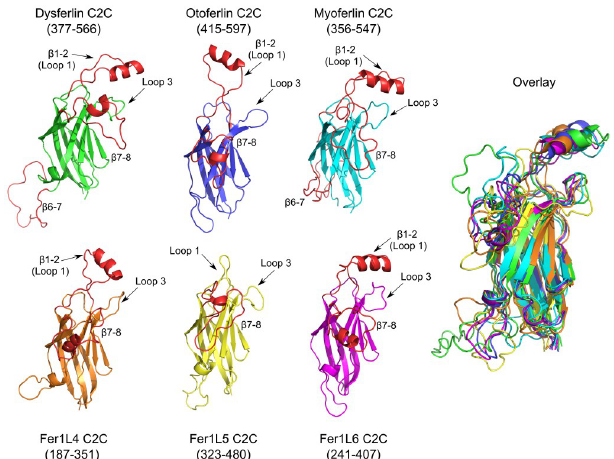
Fig 5. C2C models for dysferlin C2C (green), otoferlin C2C (blue), myoferlin C2C (cyan), Fer1L4 C2C (orange), Fer1L5 C2C(yellow), and Fer1L6 C2C (magenta). Amino acid ranges for each domain are listed under the domain label. The β 1–2, β 6–7, and β 7–8 subdomains for C2C are labeled and shown in red. The superposition of all six C2C domains is labeled as